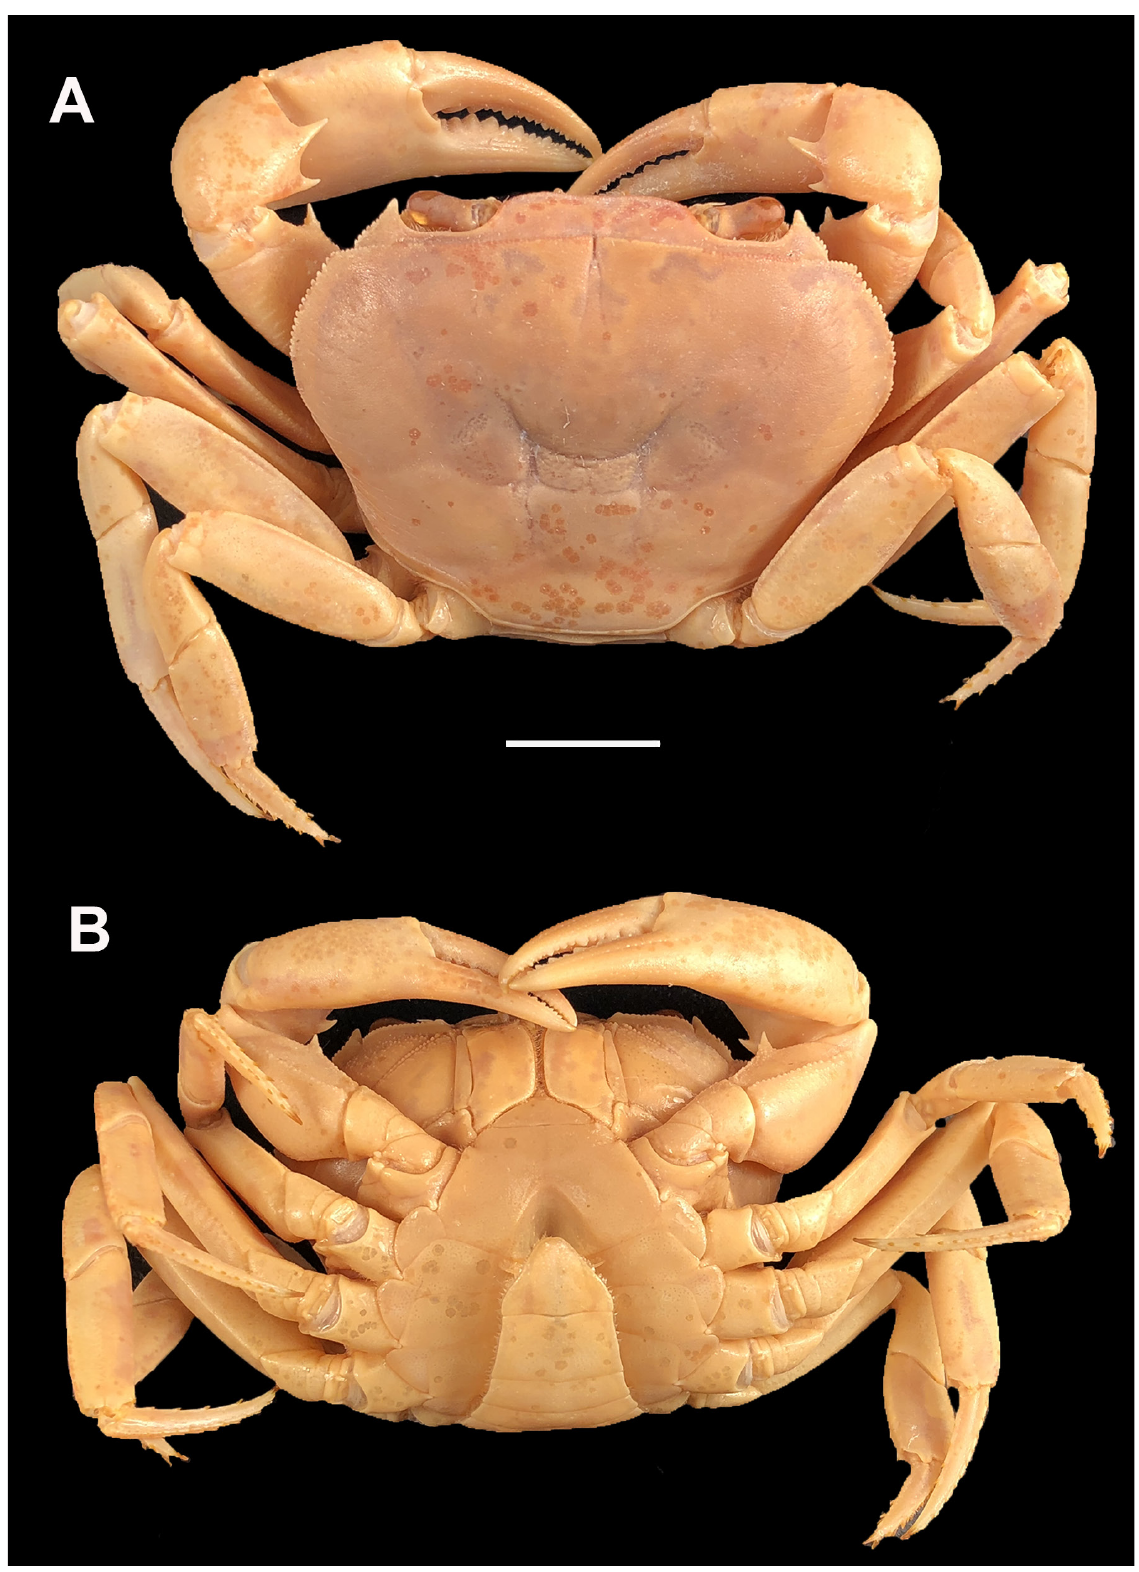
Fig. 9. Potamonautes amosae sp. nov., holotype, adult, ♂, CW 46.5 mm, from Lake Kivu, D.R. Congo (NHMUK 2018.306). A . Entire animal, dorsal view. B . Entire animal, ventral view . Scale bar = 11.3